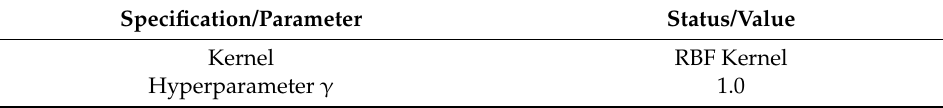
Table 3. Specifications and parameters of Gaussian process.